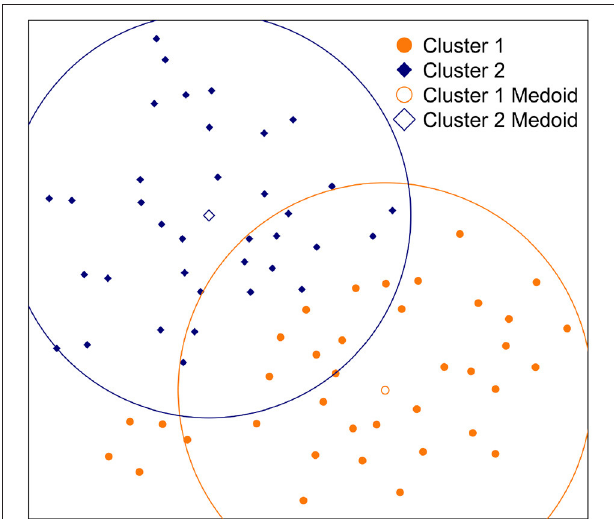
FIGURE 3 | Student practice behavior representation on 2-D t-SNE projection with PAM clustering results ( k = 2). The orange circle represents the mean Euclidean distance of all students to the Cluster 1 medoid (the orange empty square), and the blue circle represents the mean Euclidean distance of all students to the Cluster 2 medoid (the empty blue